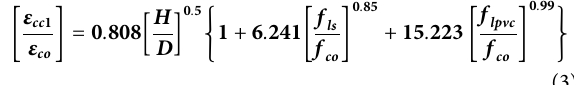
(mm/mm) = the strain of the con fi ned concrete at fi rst peak load from Equation 3. Based on the multi linear regression analysis of all 44 simulated models presented in this article, the following Equation 3 for the peak strain is proposed in which the correlation coef fi cient is 0.9442